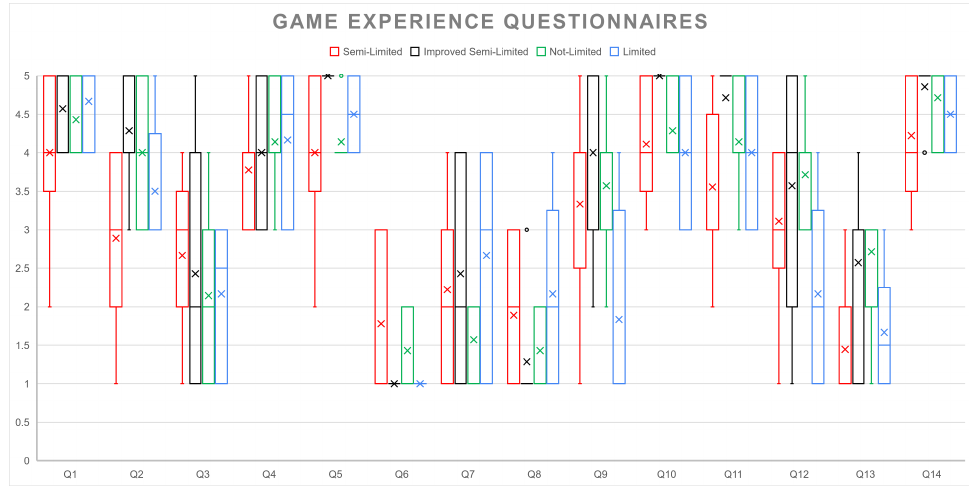
Figure 5. The box plot of the GEQ results.